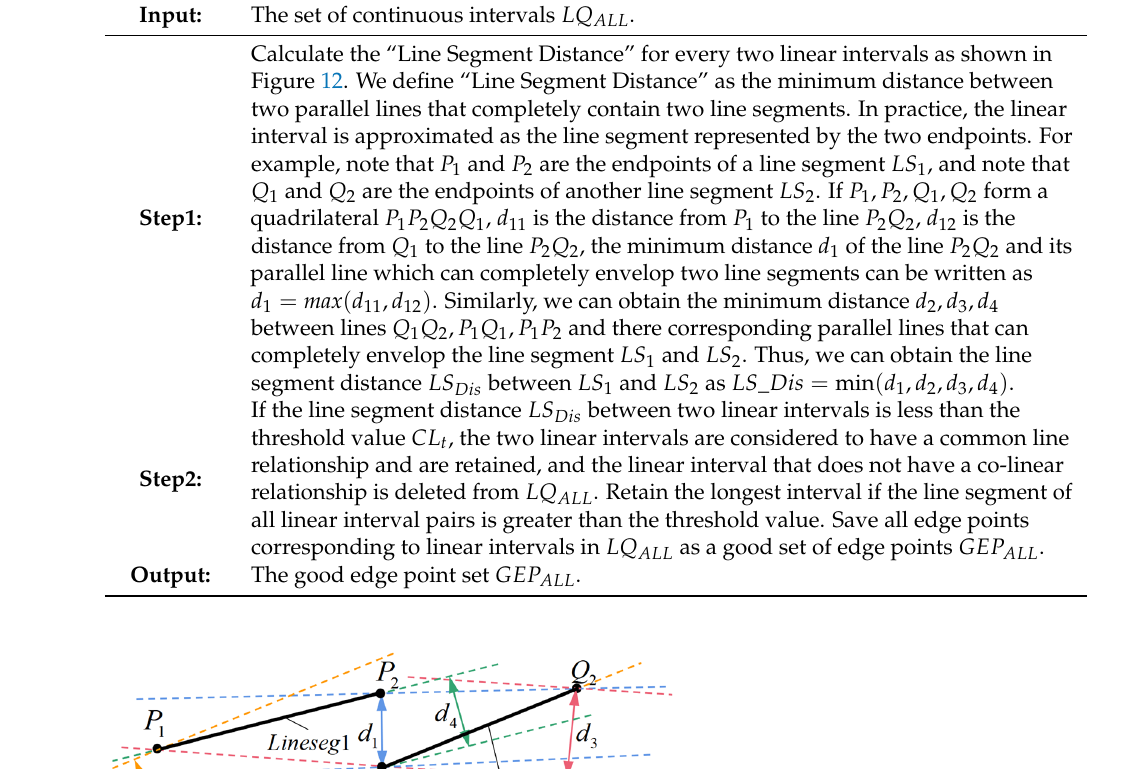
Table 5. Steps of the Co-linear Processing.